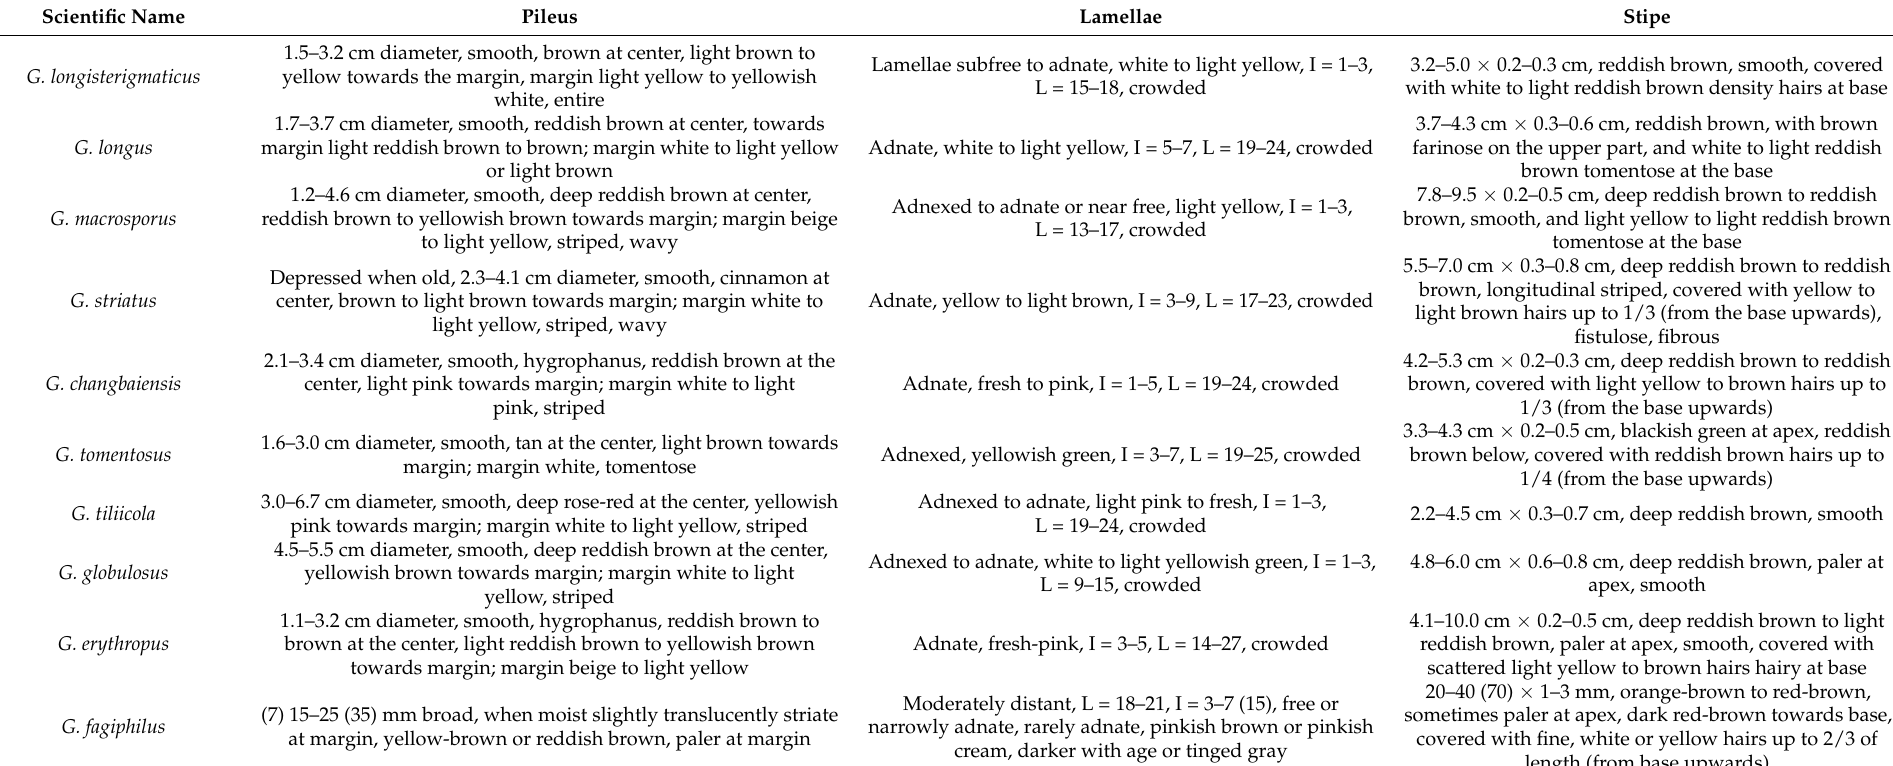
Table 2. Macrocharacteristics comparison between our new species, Gymnopus erythropus and Gymnopus fagiphilus